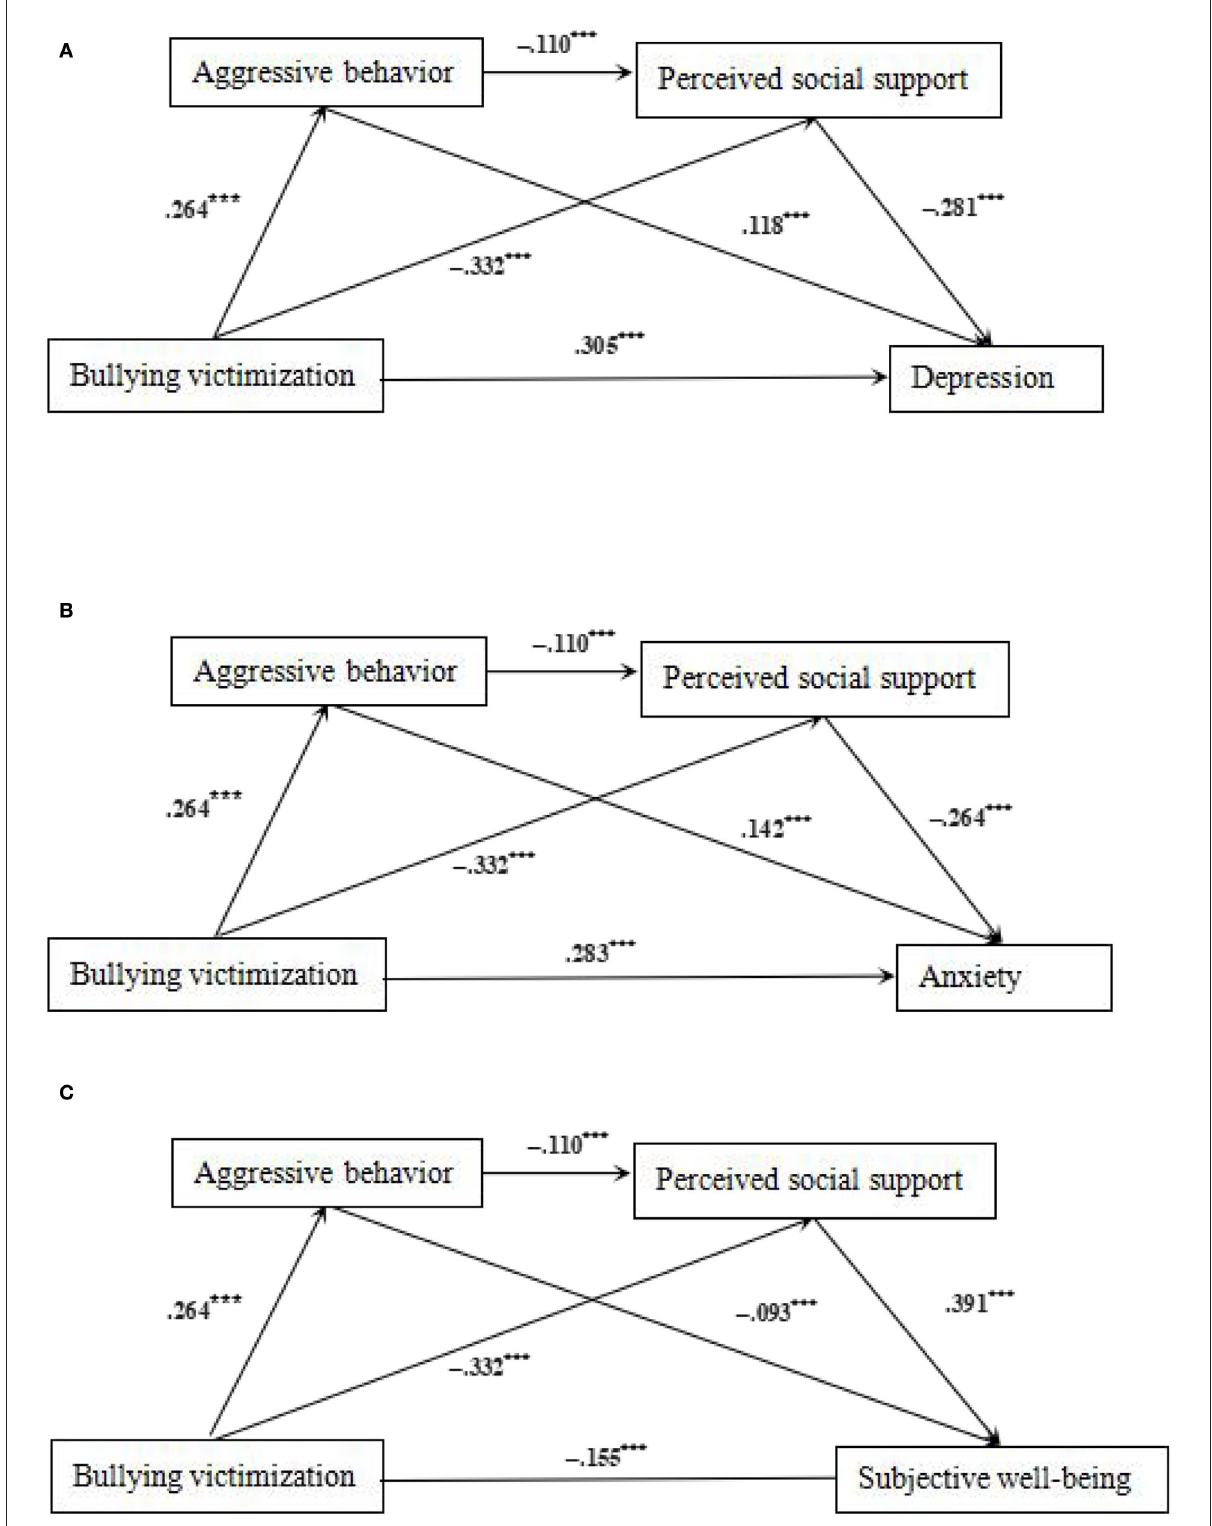
FIGURE2 (A) The mediating effect path map of bullying victimization and depression. * p < 0.05, ** p < 0.01, and *** p < 0.001. (B) The mediating effect path map of bullying victimization and anxiety. * p < 0.05, ** p < 0.01, and *** p < 0.001. (C) The mediating effect path map of bullying victimization and subjective well being. * p < 0.05, ** p < 0.01, and *** p <